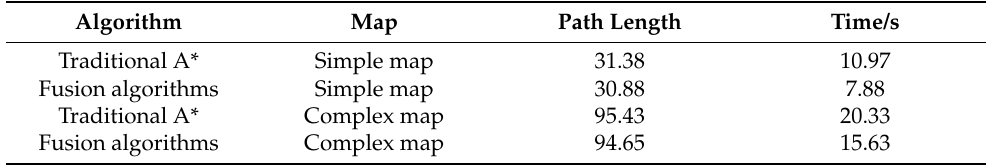
Table 1. Comparison of experimental results of the two algorithms.